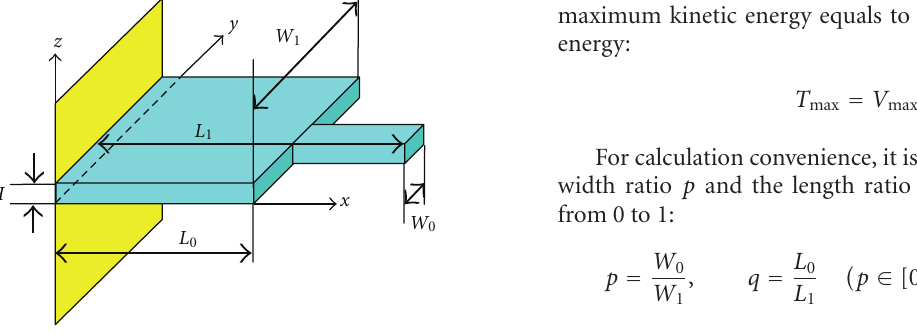
Figure 3: Schematic drawing of a T-shaped